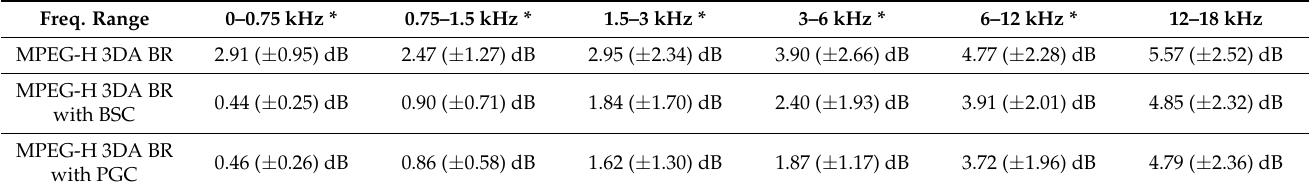
Table 3. Mean and standard deviation of the SD measurement of MPEG-H 3DA BR, and MPEG-H 3DA BR with PGC and BSC, respectively.